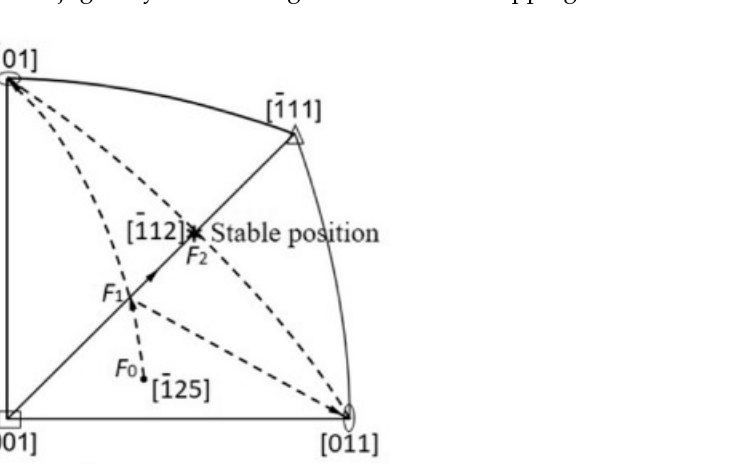
(cid:2) (cid:3) 101